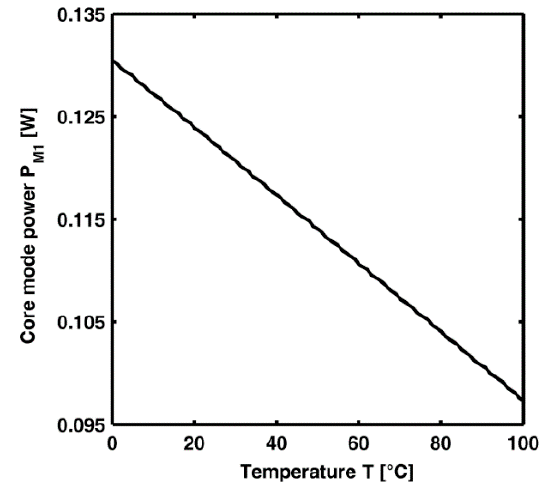
Figure 9. Power P M1 of the M 1 mode at pump wavelength versus temperature at the output section of Figure 9. Power P of the M mode at pump wavelength versus temperature at the output M1 1 CLPG 2 , P p = 1 section of CLPG , P = 1 W. 2 p